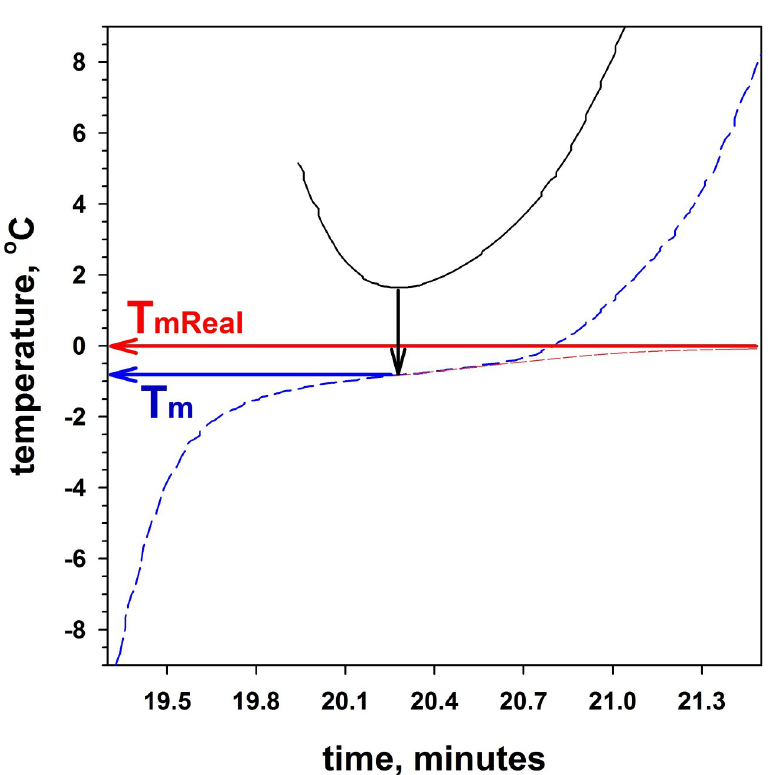
Fig 5. Determination of the melting point of ice, T m . The blue dashed line is an example of the time dependence of sample temperature during heating. The black solid line is the first derivative of the blue curve. The minimum of the first derivative graph allows determining the inflection point of the blue dashed curve (shown by the black arrow) from the position of which T m is determined (shown by the blue arrow). The red dashed line shows a probable change in the experimental curve (blue) for the case when the sample is voluminous and the thermometer can precisely measure the average temperature of the sample. The red dashed line asymptotically tends to the real melting point of ice, T mReal . The red arrow shows the real melting point of